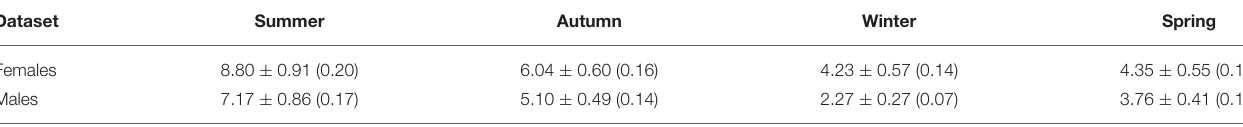
TABLE 2 | The mean number of sightings ± SE for adult female ( n = 81) and adult male ( n = 59) dolphins pooled by season.